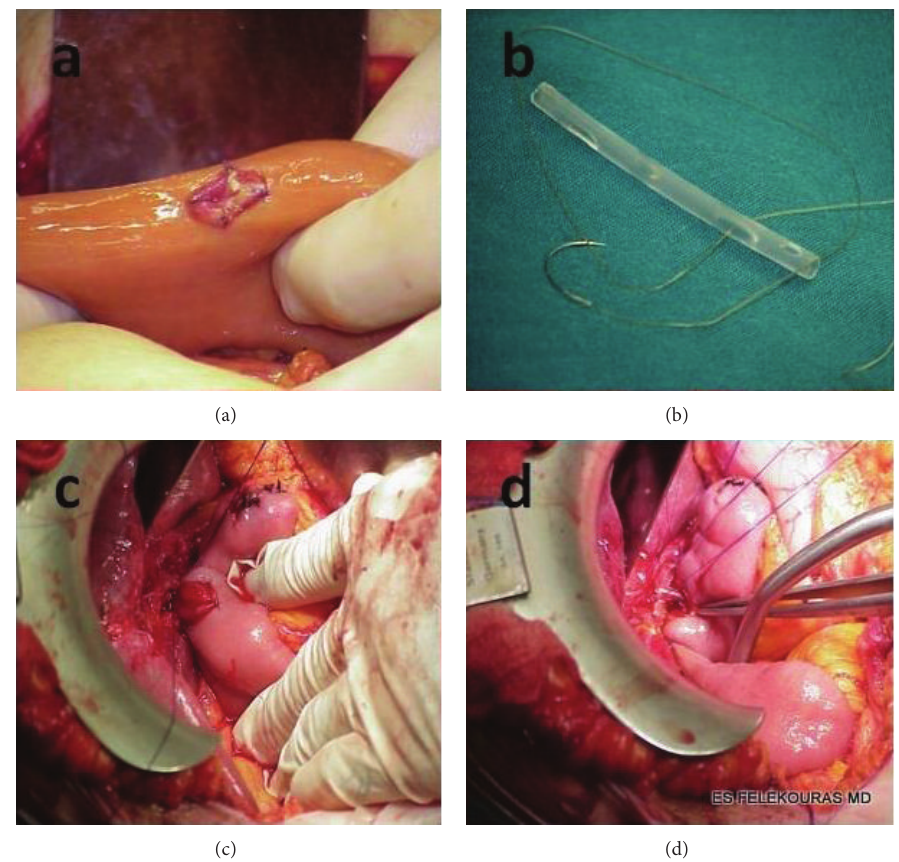
Figure 2: Operative technique of end-to-side Roux-en-Y hepaticojejunostomy. (a) Creation of mucosa-to-mucosa intestinal site of anastomosis. (b) Construction of endoanastomotic (in–in) stent. (c) Hepaticojejunostomy using 4-0 PDS interrupted sutures. (d) Hepaticojejunostomy with endoanastomotic